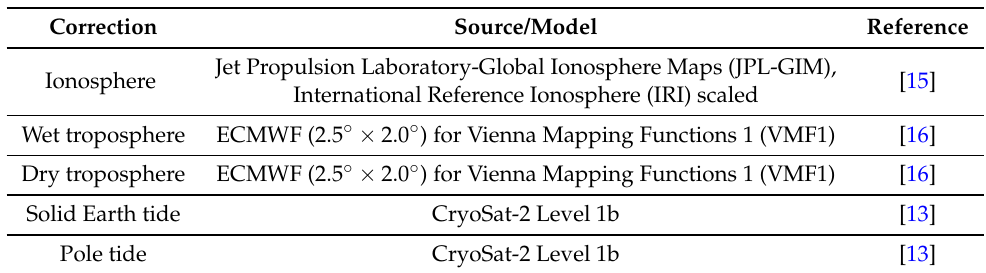
Table 1. Geophysical corrections applied within this